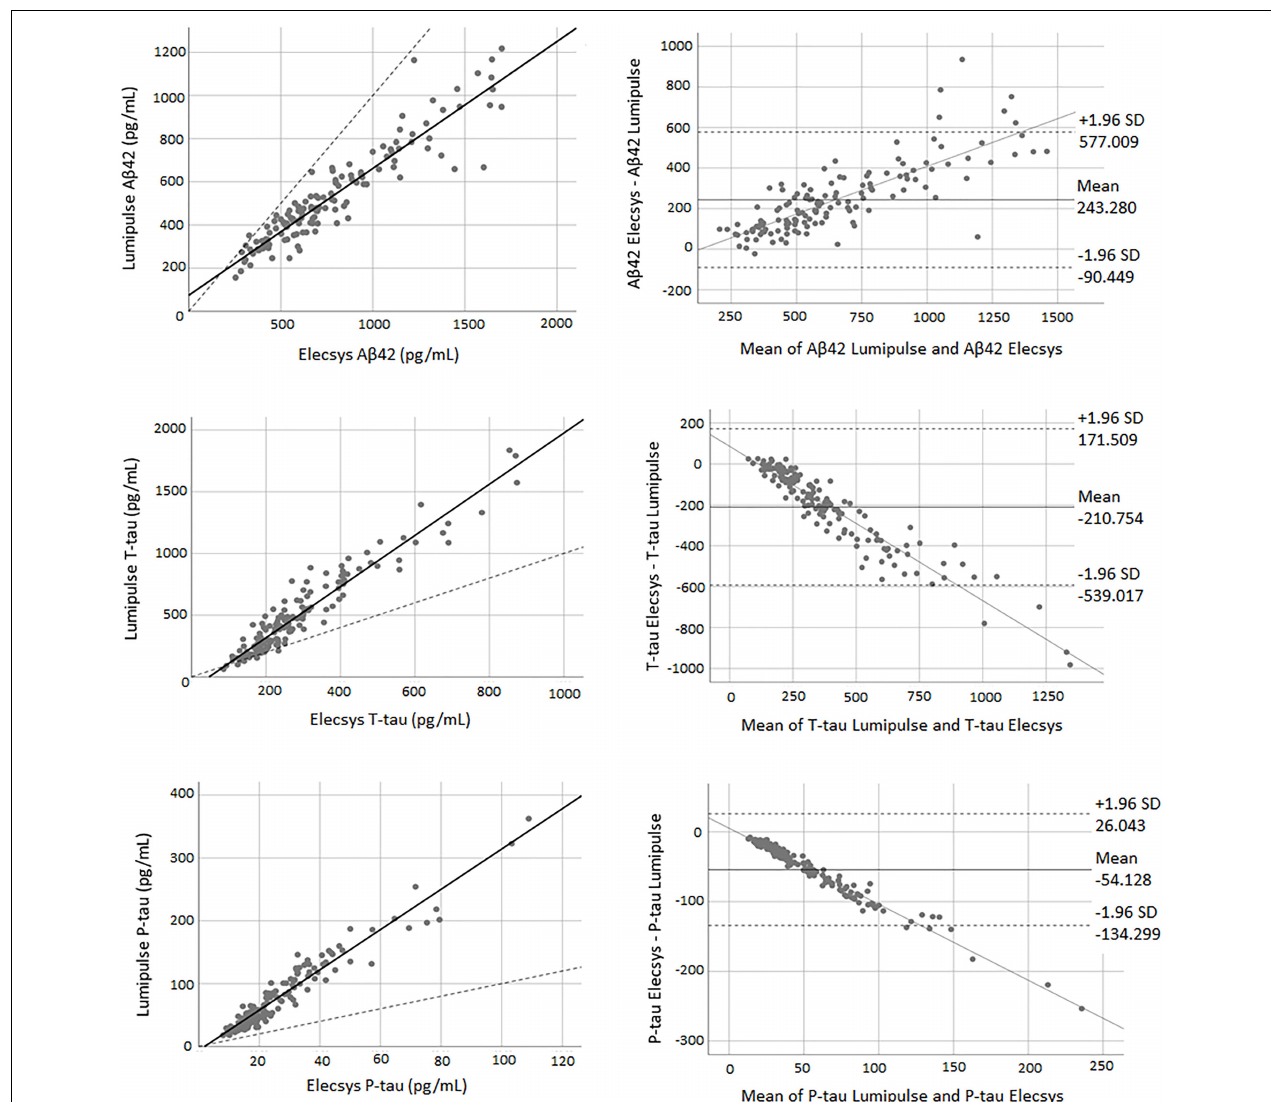
FIGURE 3 | The correlation and Bland-Altman plots for A β 42, T-tau, and P-tau measurements obtained by Lumipulse and Elecsys methods (for P-tau and T-tau n = 145; for A β 42 n = 137). Each point is defined as the measurement of Lumipulse and Elecsys assays on the same biological sample. In correlation plots, the solid lines represent the estimated regression line, and the dotted line represents the identity line ( x = y ). In the Bland-Altman plots, solid lines represent the slope observed.